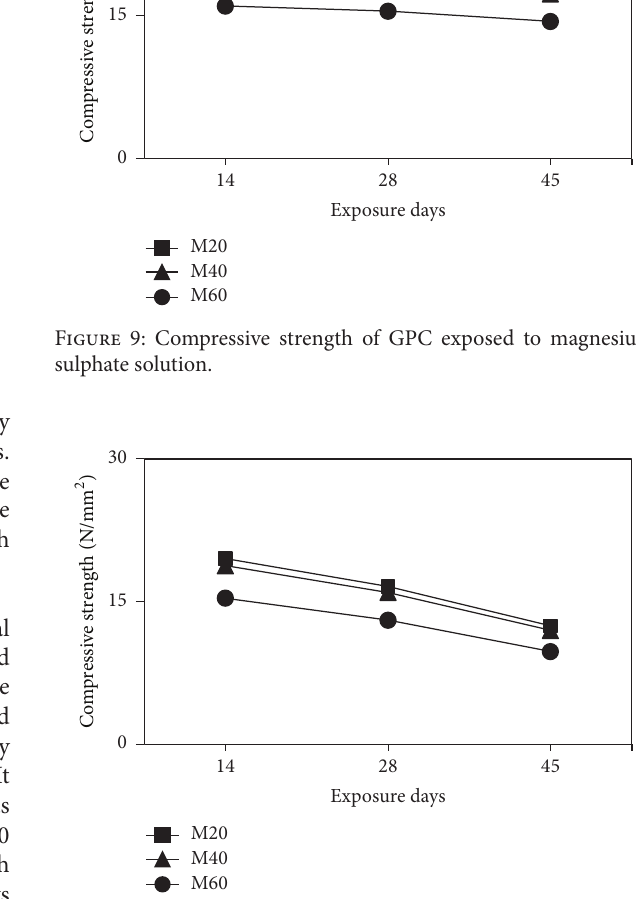
Figure 10: Compressive strength of GPC exposed to sulphuric acid